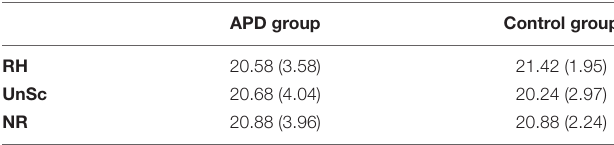
TABLE 2 | Means and SDs (in parentheses) of WRRC raw scores RH n , UnSc n , and NR n , i.e., the number of 1st and 2nd syllables recognized in each condition respectively, for APD and neurotypical children.